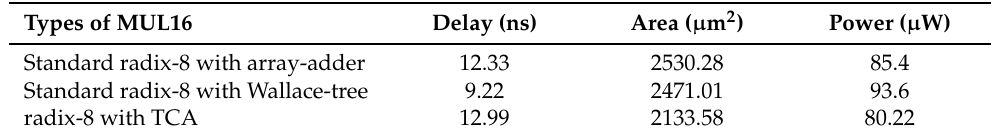
Table 3. Comparison of 16-bit multipliers (clock frequency = 50 MHz).